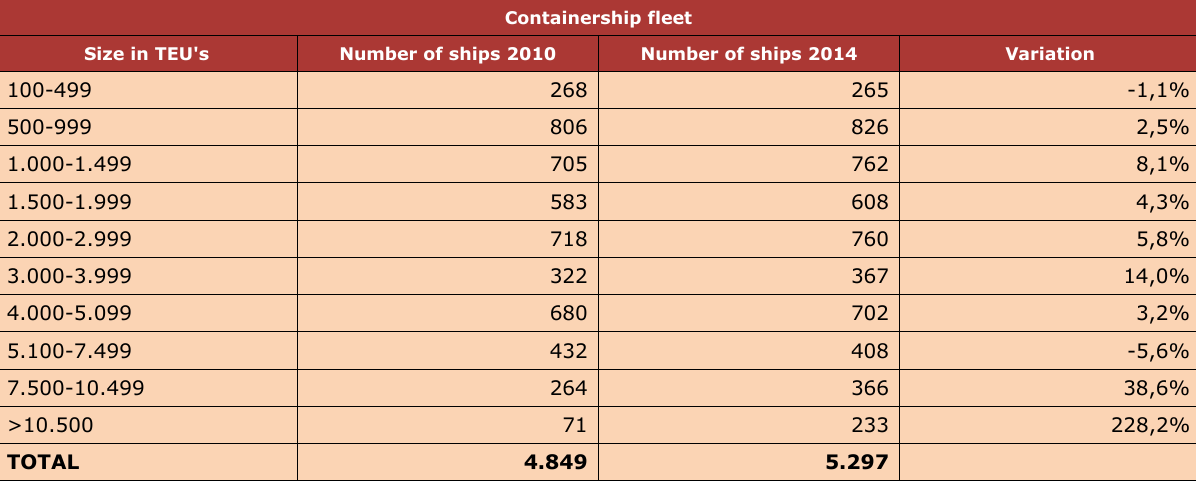
Table 4. Containership fleet